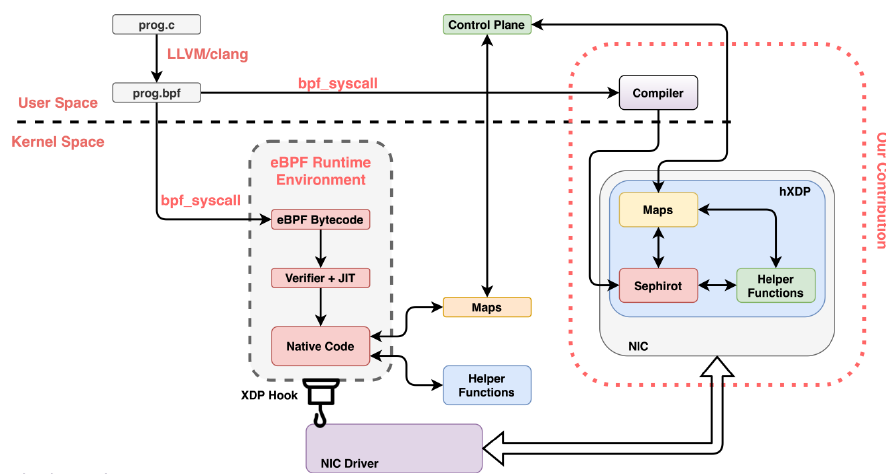
Figure 4. hXdp hardware design of logic architecture.